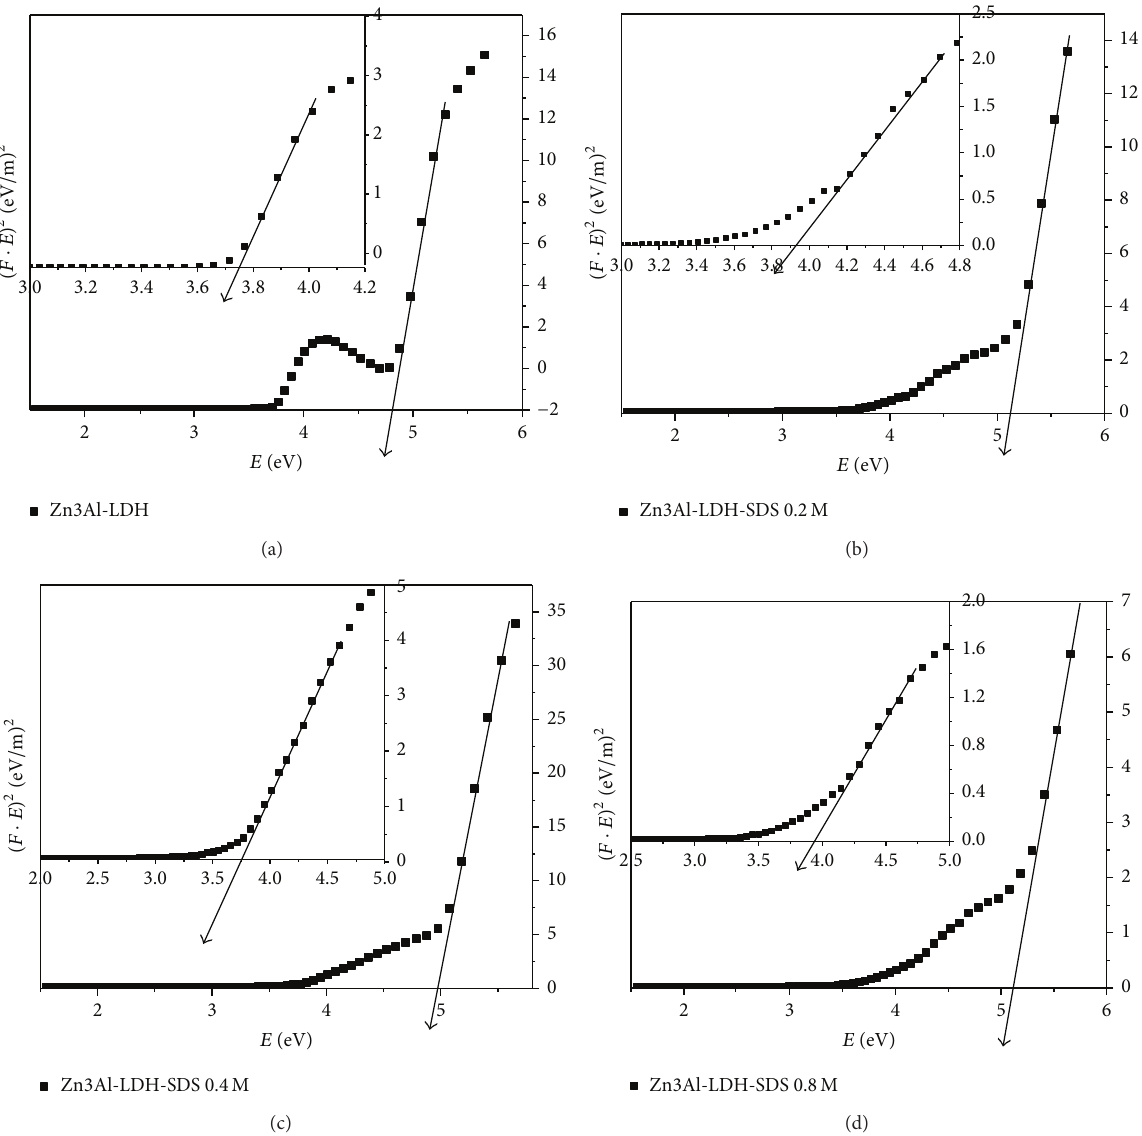
Figure 4: Kubelka-Munk transformed reflectance spectra of Zn3Al–NO 3 –LDH and LDH-SDS in different concentrations.